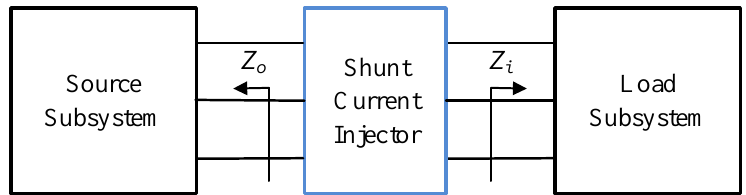
Figure 2. General diagram for impedance measurement using the line-to-line current injection .